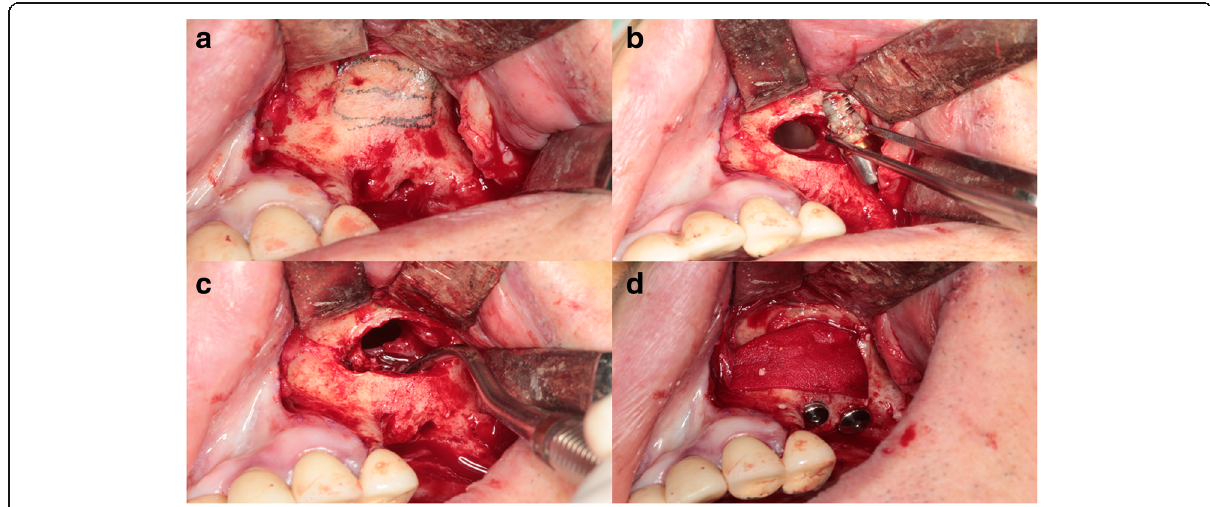
Fig. 3 Intraoperative photographs. a Marking of bony window. b Removal of the displaced implant through the upper part. c Sinus elevation through the lower part. d Implant installation with sinus bone graft using absorbable membrane and fibrin glue